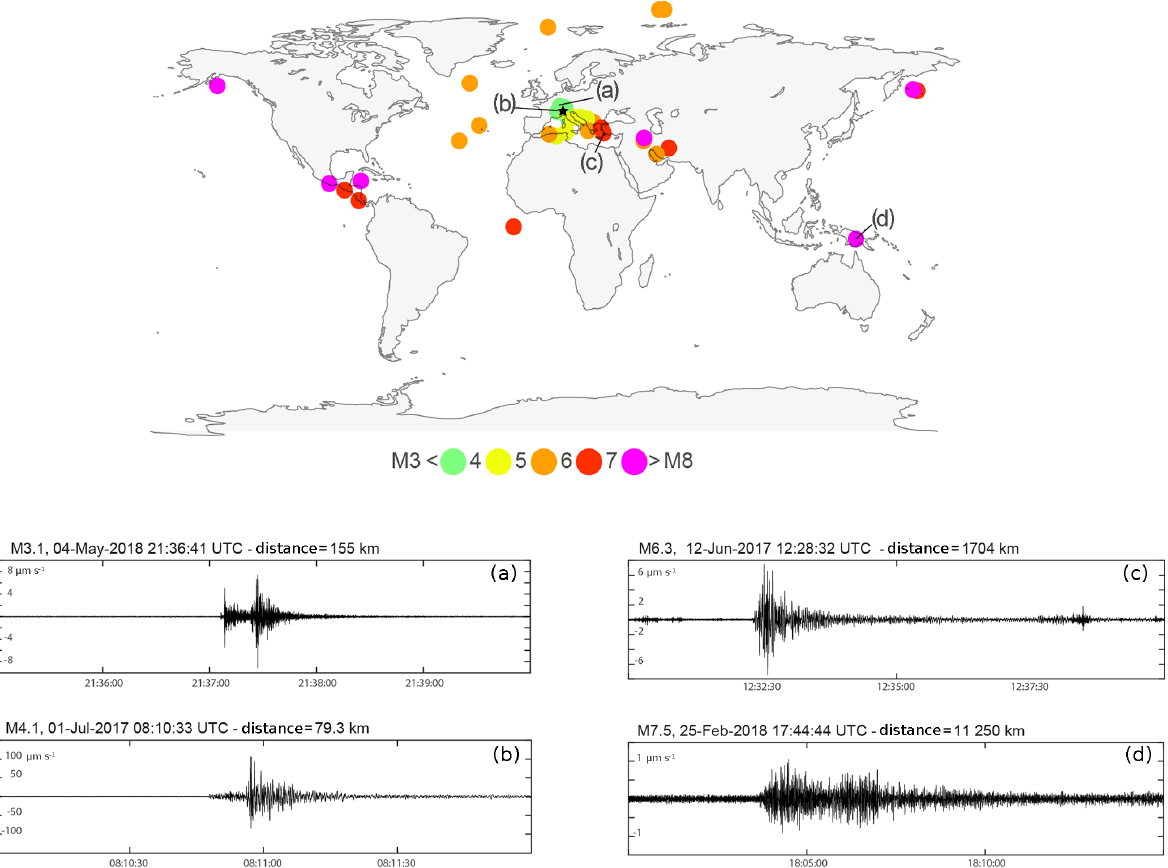
Figure 3. Performance of the RS-1 station in recording earthquakes. (top panel) Spatial distribution of earthquake events identified in the RS- 1 waveforms out of a catalogue of 64 earthquakes that occurred within the 1-year time period at distances up to 15000km. (a–d) Examples of seismic signals recorded by RS-1 associated with earthquakes of different magnitudes that occurred at increasing distances from the monitoring station. Signals are band-pass filtered (Butterworth, second-order) between 0.5 and